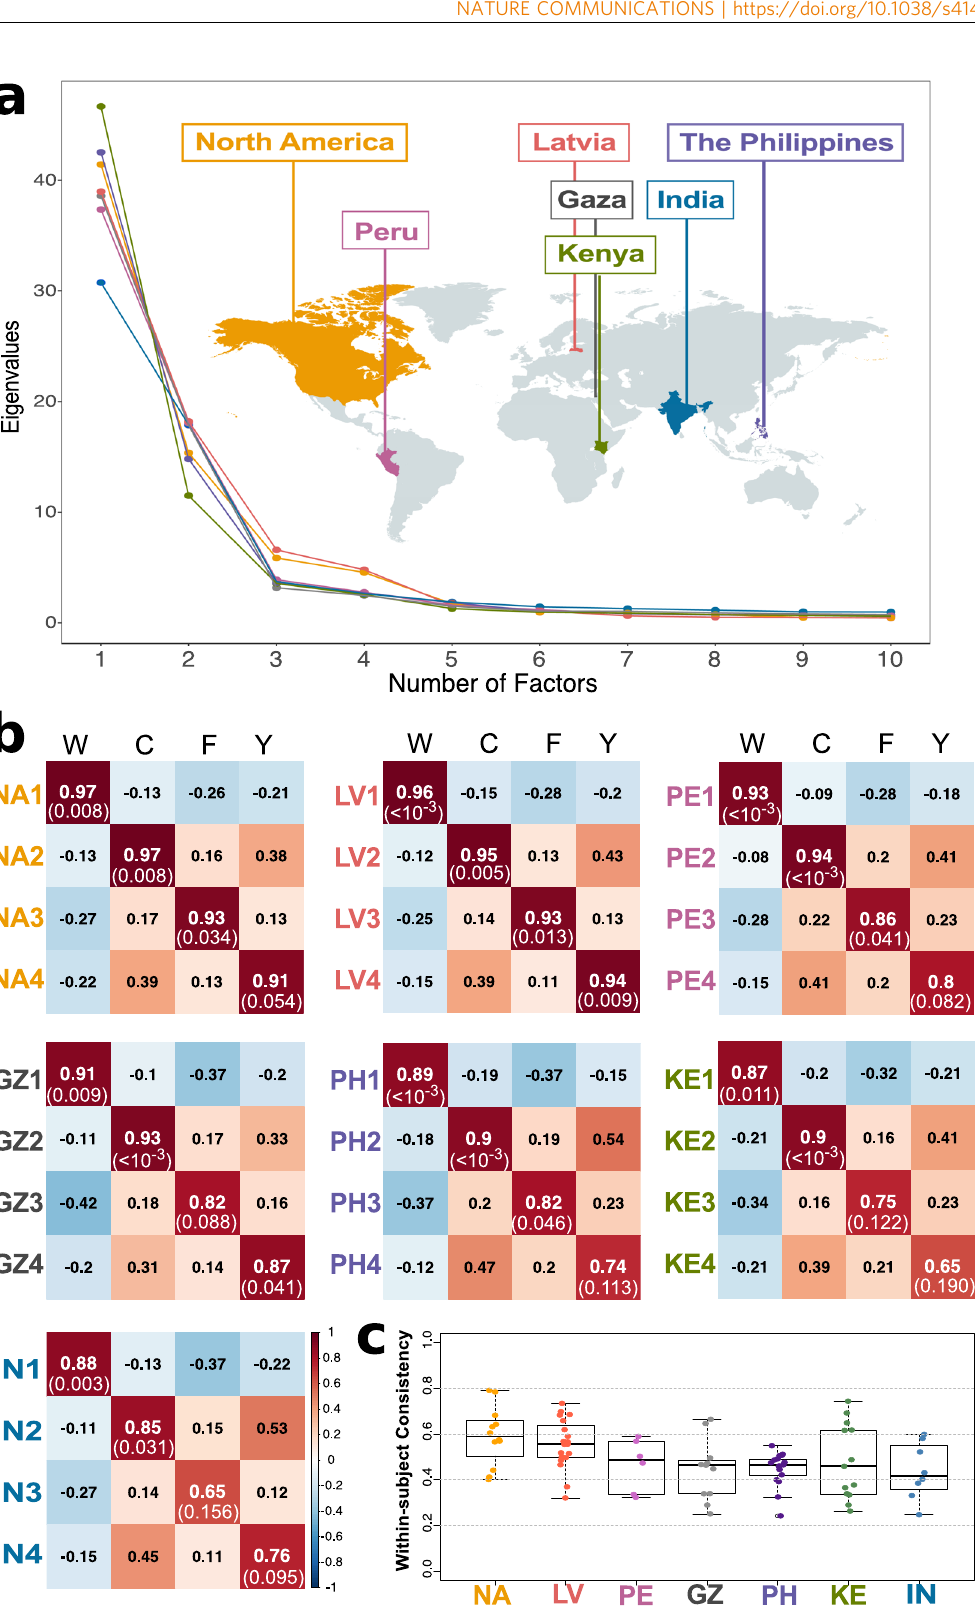
four-dimensional space be reproduced in a single participant? This important question has been dif fi cult to address since one needs to have complete data per participant 52 . We met this challenge by collecting ratings on all traits for all faces from every participant in Study 2 (requiring approximately 10 h of testing per participant; see Methods).